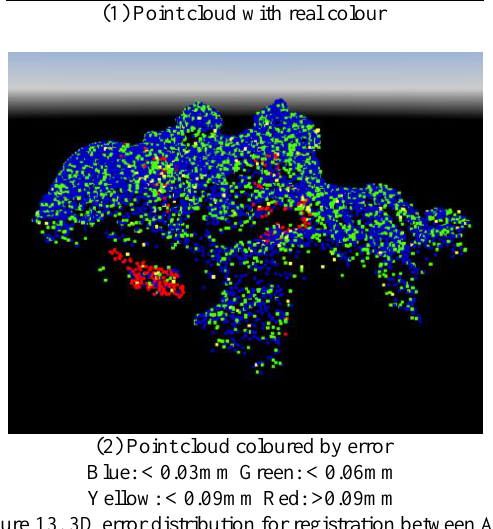
Figure 13. 3D error distribution for registration between A-1 and